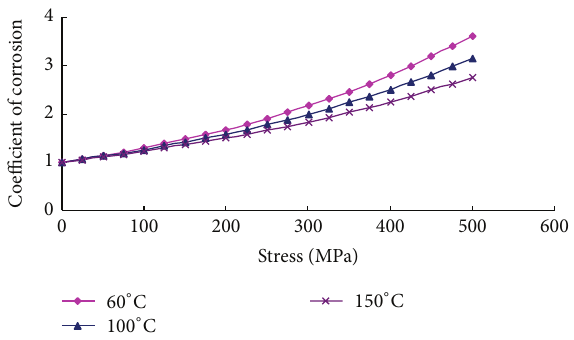
Figure 3: The relationship between corrosion coefficient and aver- age normal